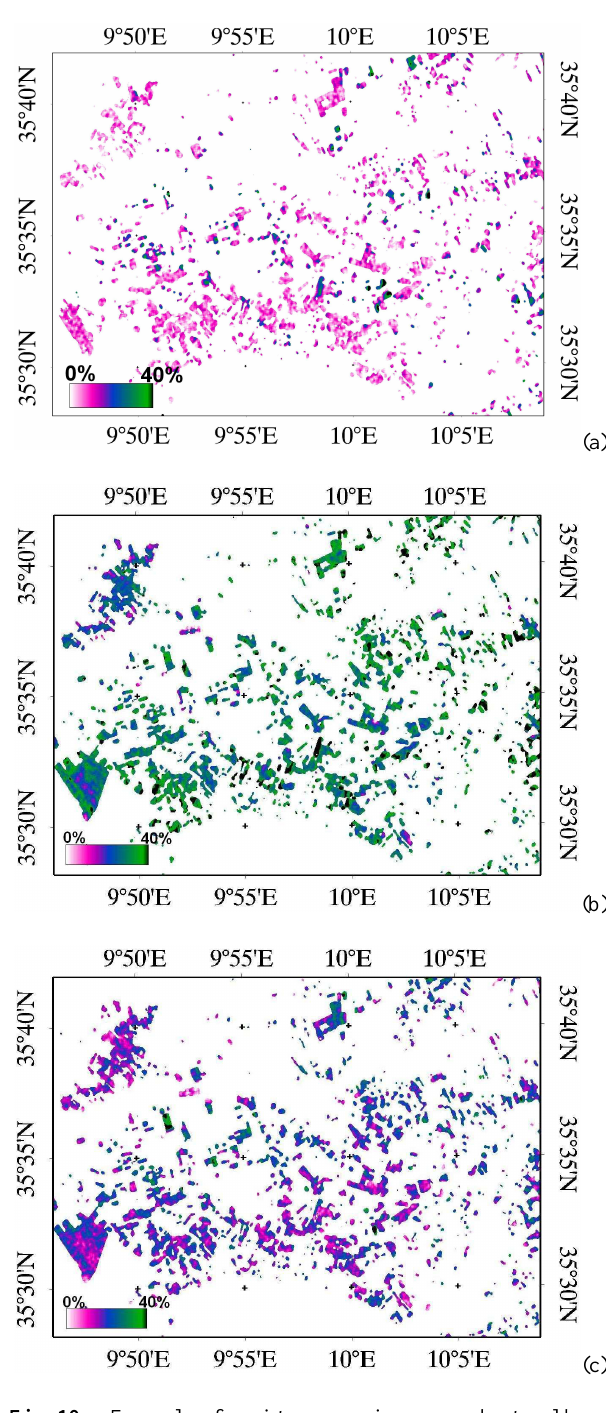
Fig. 10. Example of moisture mapping over wheat fields on three different dates: (a) 16 January 2009, (b) 20 Feburary 2009, (c) 27 March